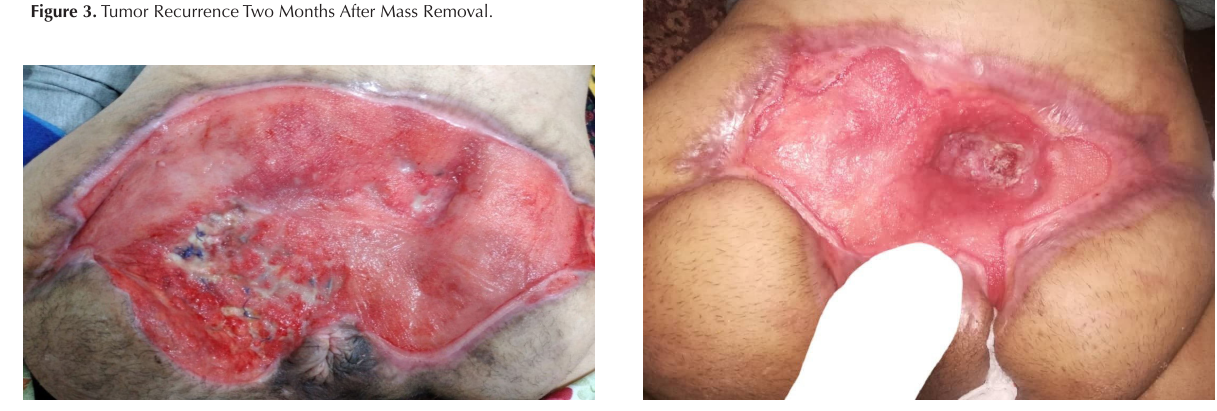
Figure 4. Three Weeks After the Removal of the Sacrum. Figure 5. Wound Condition One Year After the